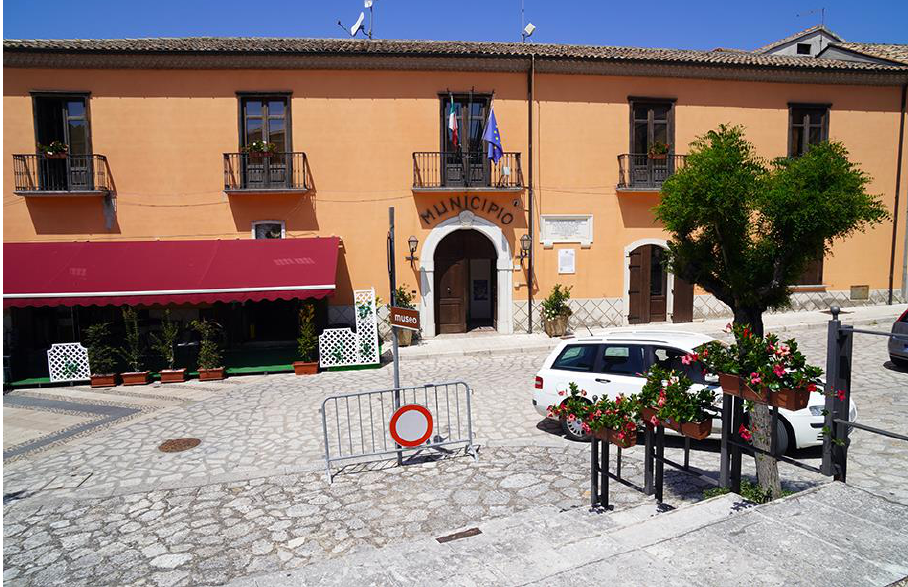
Geosciences 2021 , 11 , x FOR PEER REVIEW Figure 74. Guardia dei Lombardi: the new Town Hall of village (photos by [35,36]).